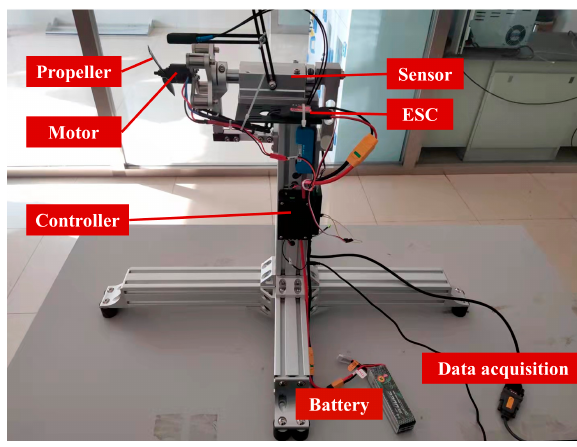
Figure 11. Electric propulsion measurement system. Table 3. Specifications of the electric propulsion test bench.